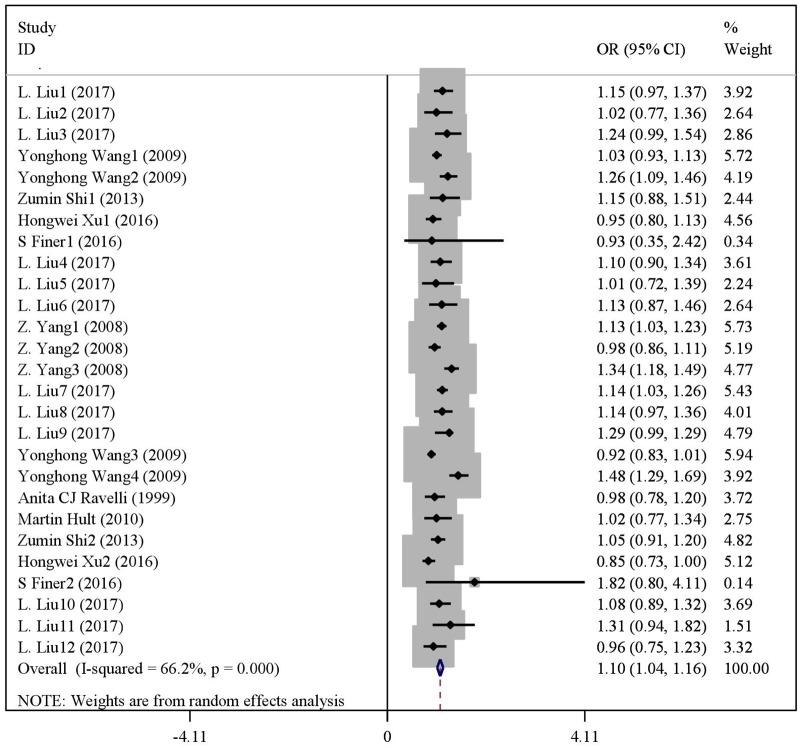
The forest plot of famine exposure and the risk of overweight.